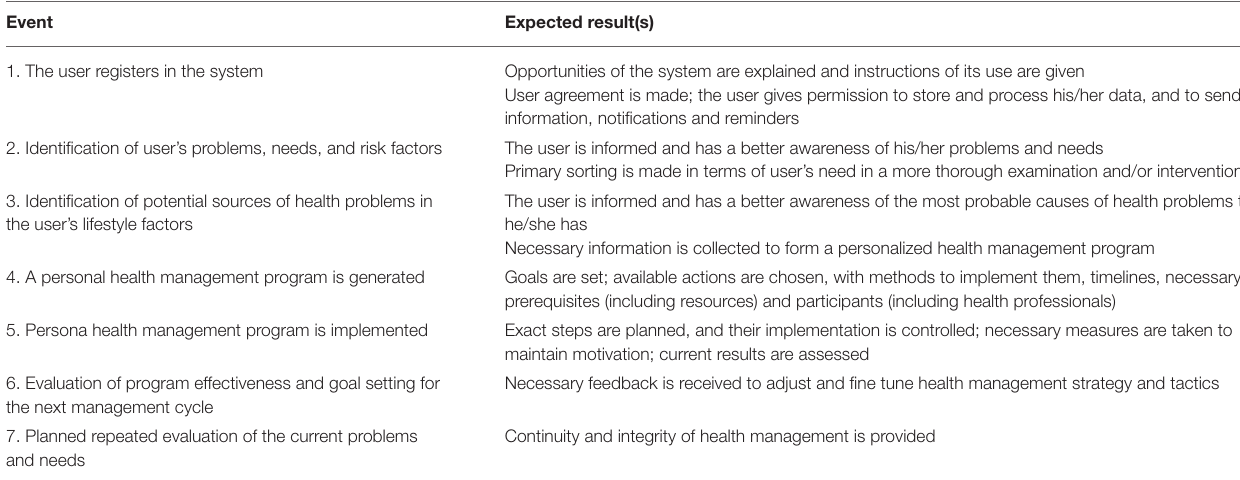
TABLE 5 | Possible sequence of user’s interactions with